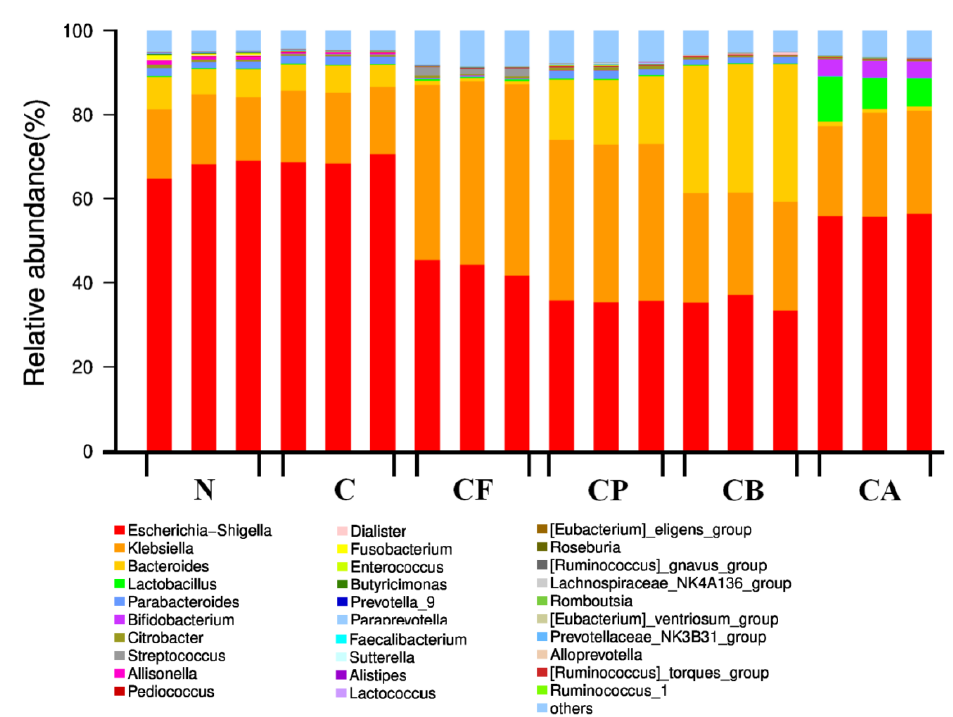
Figure 5. Relative abundance by genus level. Each column represents one sample. Different colors indicate different bacteria in genus.